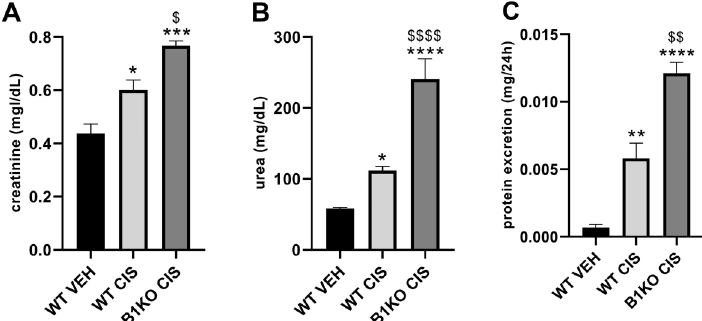
Figure 1. Kinin B1 receptor de fi ciency worsens cisplatin-induced renal dysfunction. Serum creatinine ( A ), urea ( B ), and protein excretion ( C ). Data are reported as means ± SE (n=4 – 5 per group). *P o 0.05, **P o 0.01, ***P o 0.001, ****P o 0.0001 compared to the WT (wild type) VEH (vehicle) group; $ P o 0.05, $$ P o 0.01, $$$$ P o 0.0001 compared to the WT CIS (cisplatin) group (one-way ANOVA followed by post hoc Tukey ’ s test).